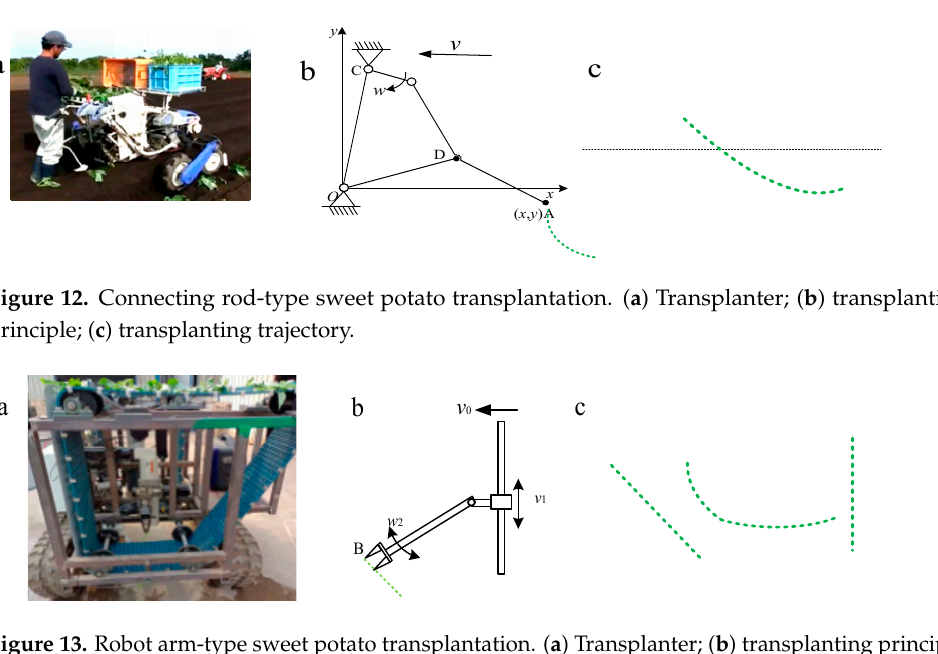
Figure 11. Chain-clip sweet potato transplantation. ( a ) Transplanter; ( b ) transplanting principle; ( c ) transplanting trajectory.